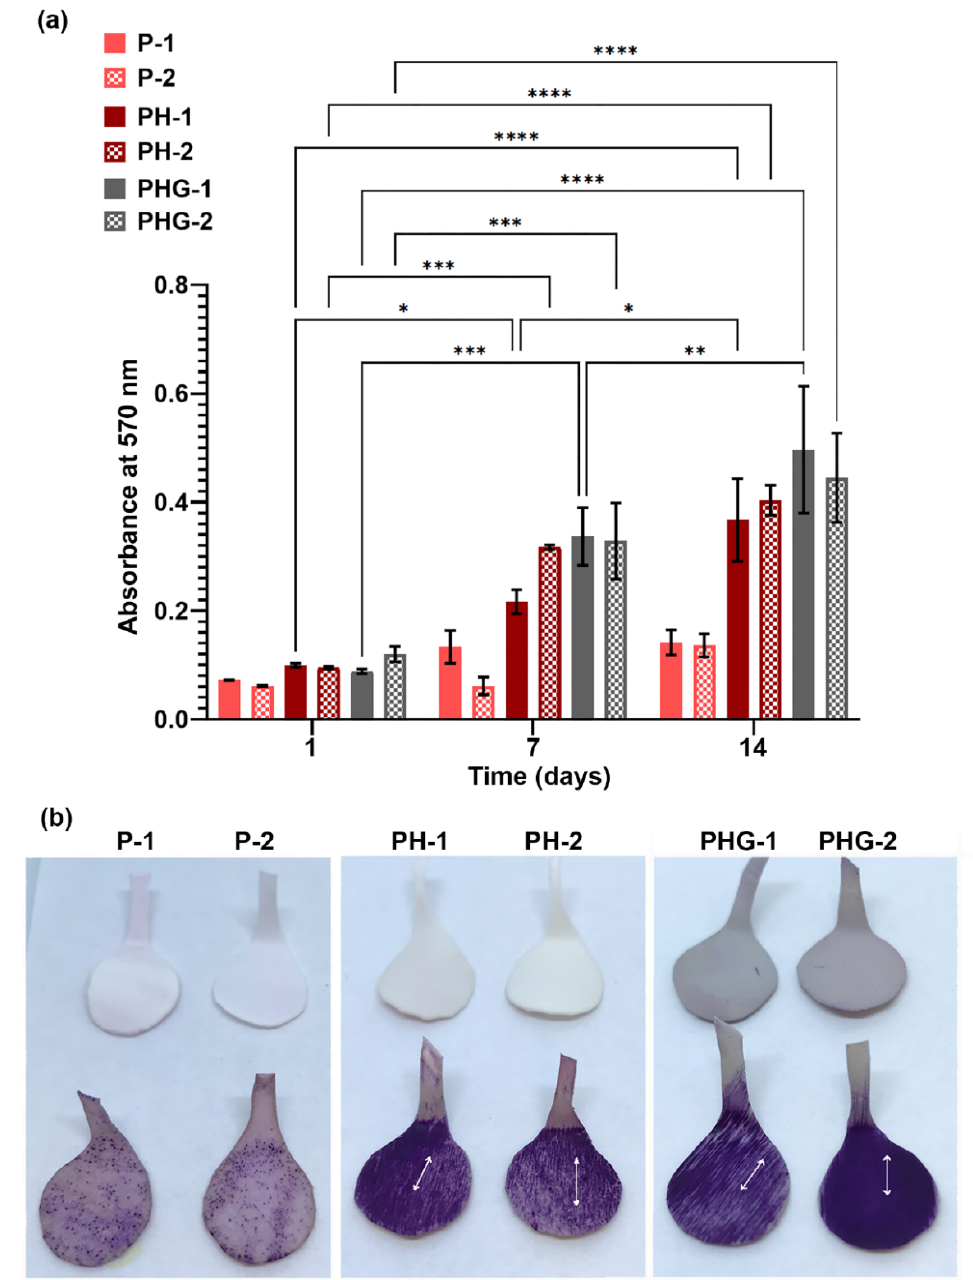
Figure 8. ( a ) In vitro viability of osteoblast cells cultured on P, PH, PHG membranes for up to 14 days based on MTT assay. ( b ) Macroscopic images demonstrating the formation of formazan crystals on the P, PH and PHG constructs at 14th day of culture. Arrows indicate the direction of the grooves on the patterns. Circular-cut membranes are 9.8 mm in diameter; tails were left for ease of handling. Statistical significance; * p ≤ 0.05, ** p ≤ 0.01, *** p ≤ 0.001, **** p ≤ 0.0001.